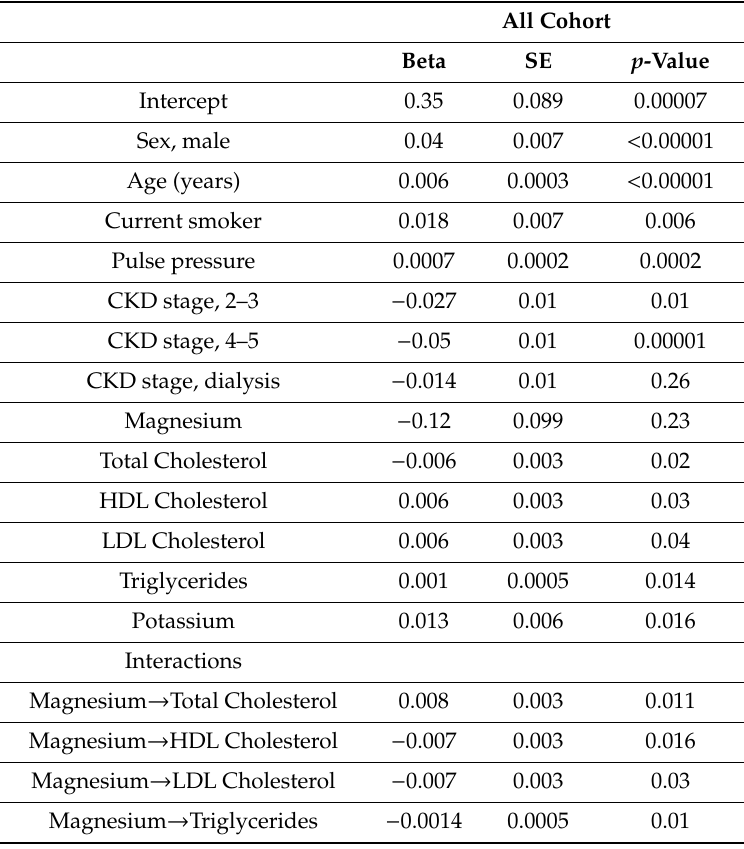
Table 4. Multivariate linear e ff ects model for cIMT with first-order